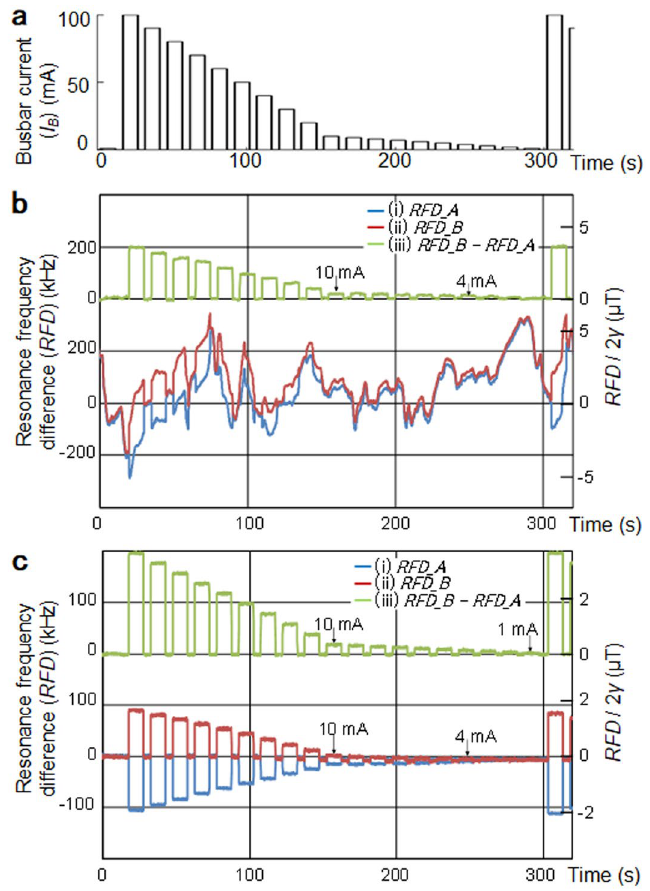
Figure 4. Small current measurement from an external source. ( a ) Pulse train input of 100 mA ~ 1 mA. ( b ) Measured resonance frequency difference ( RFD ), (i) RFD_A , (ii) RFD_B , and (iii) RFD_B − RFD_A in the daytime. 10 μT pp external noise in (i) RFD_A and (ii) RFD_B is eliminated in (iii) RFD_B − RFD_A and ~ 4 mA is detected in (iii). ( c ) The measurement result at midnight with little external magnetic field noise. ~ 4 mA is detected in (i) RFD_A and (ii) RFD_B , and ~ 1 mA is detected in (iii) RFD_B − RFD_A